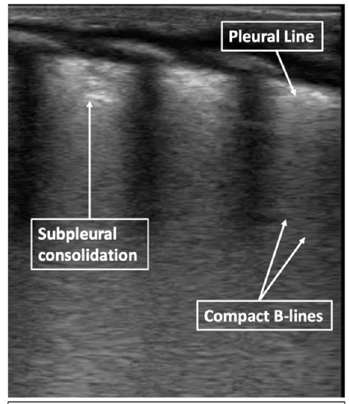
Figure 6. Severe RDS in B-mode. Compact B-lines (white lung), subpleural consolidation, thick and irregular pleural line.